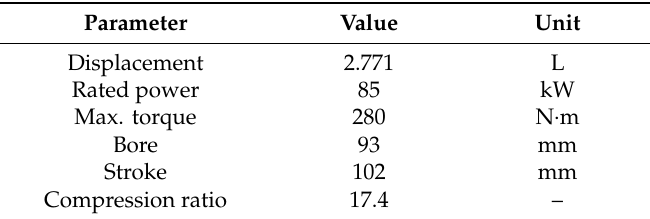
Table 1. The main technical parameters of the BJ493ZLQ3